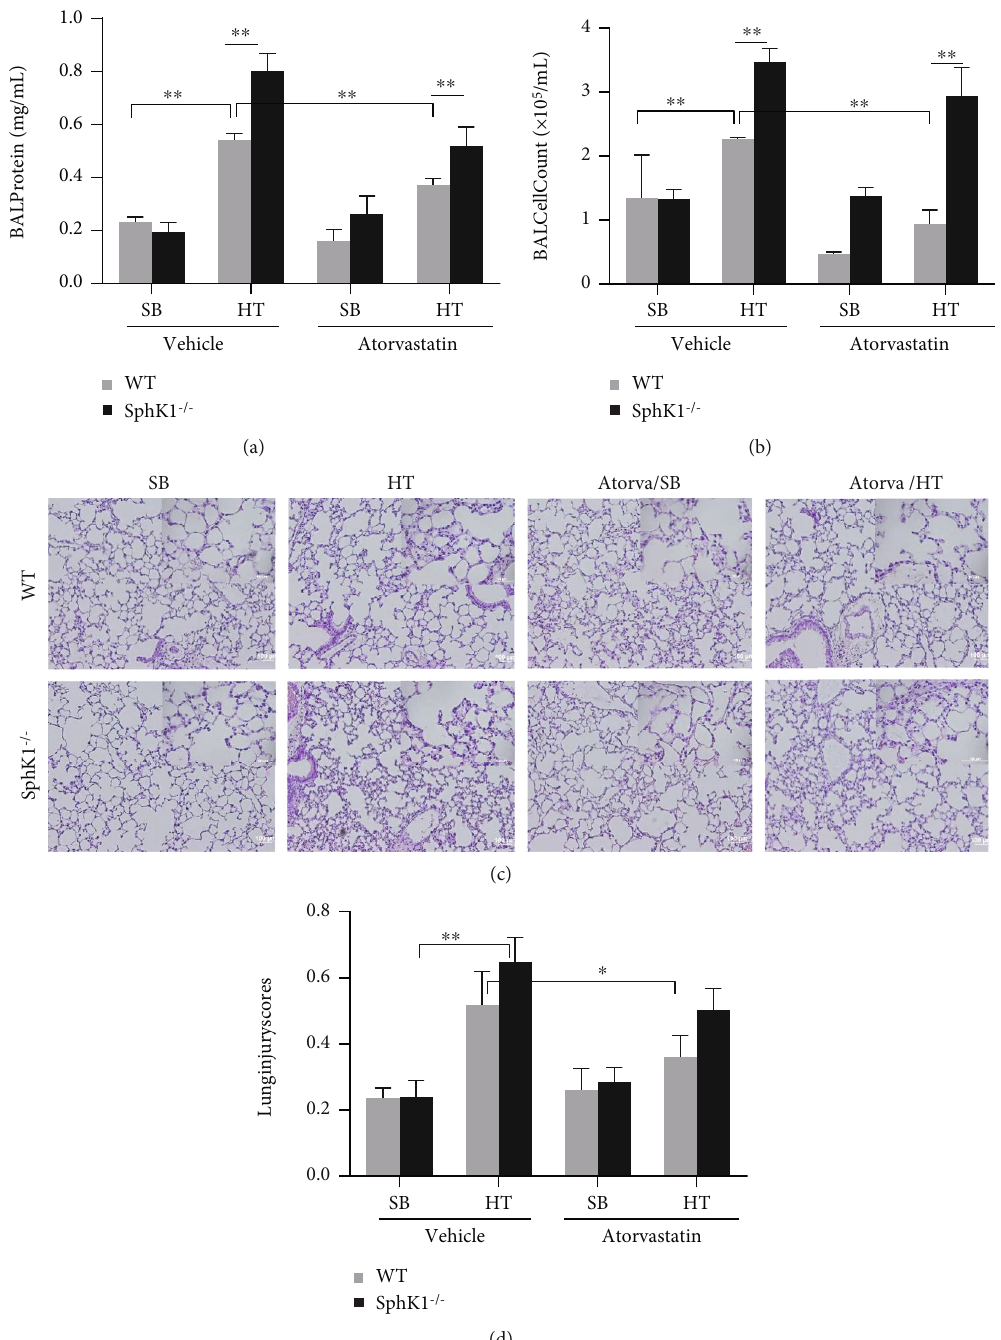
Figure 1: Atorvastatin attenuated VILI-mediated lung permeability but SphK1 knockout reversed this e ff ect. WT and SphK1 -/- were treated with atorvastatin overnight as described in Materials and Methods. The next day, the mice underwent high tidal volume ventilation (40 ml/ kg, 65 breaths/min, 4 hours). After ventilation, the mouse BAL and lung were harvested for protein, cellular, and histology analysis. (a, b) Compared to spontaneously breathing control mice, HT signi fi cantly induced both protein and cells in BAL. Atorvastatin treatment attenuated the HT-mediated induction of protein and cells in BAL. Compared to WT mice, HT-induced SphK1 -/- mice had more protein and cell in fi ltration in the BAL. However, SphK1 knockout signi fi cantly abolished the atorvastatin-mediated anti-in fl ammatory e ff ect in SphK1 -/- mice. (c, d) Compared to WT mice, HT-induced SphK1 -/- mice had signi fi cantly more cell fi ltration and alveolar structure damage with higher lung injury scores. Moreover, SphK1 knockout reversed atorvastatin-mediated cell fi ltration inhibitory e ff ect on WT mice ( ∗ P < 0 : 05 , ∗∗ P < 0 : 01